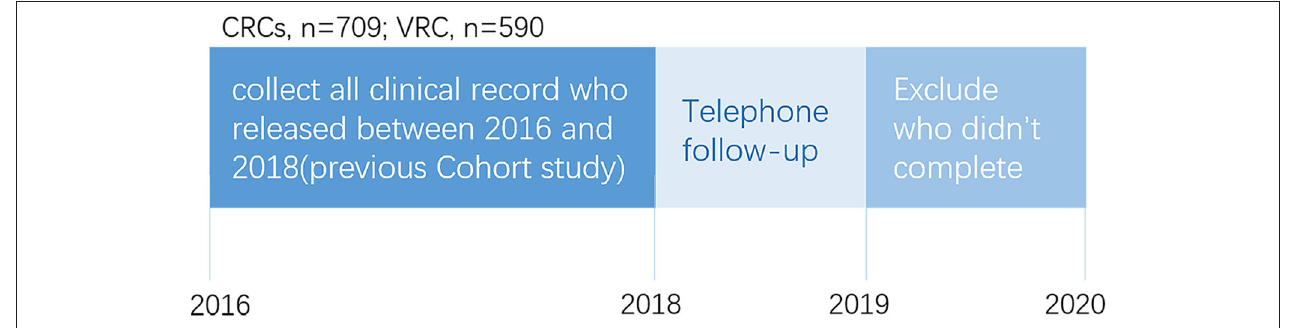
FIGURE 1 | The overall profile of